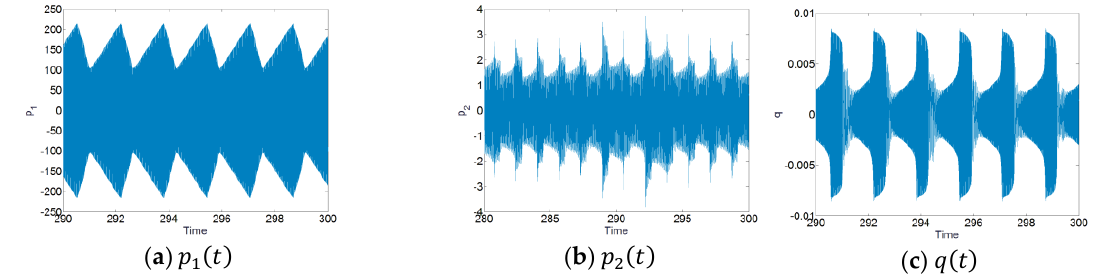
with circle stand for numerical results. Blue curves stand for analytical results.